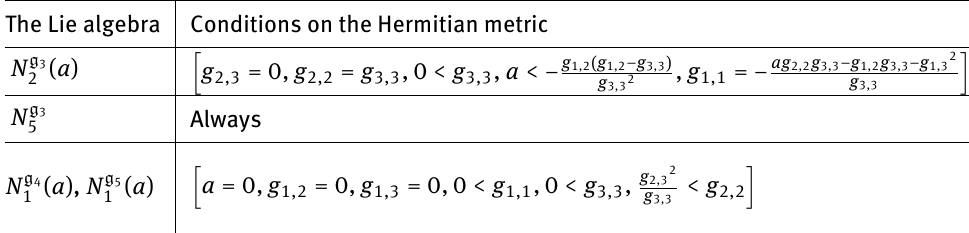
Table 5: Examples of infinitely balanced Lie